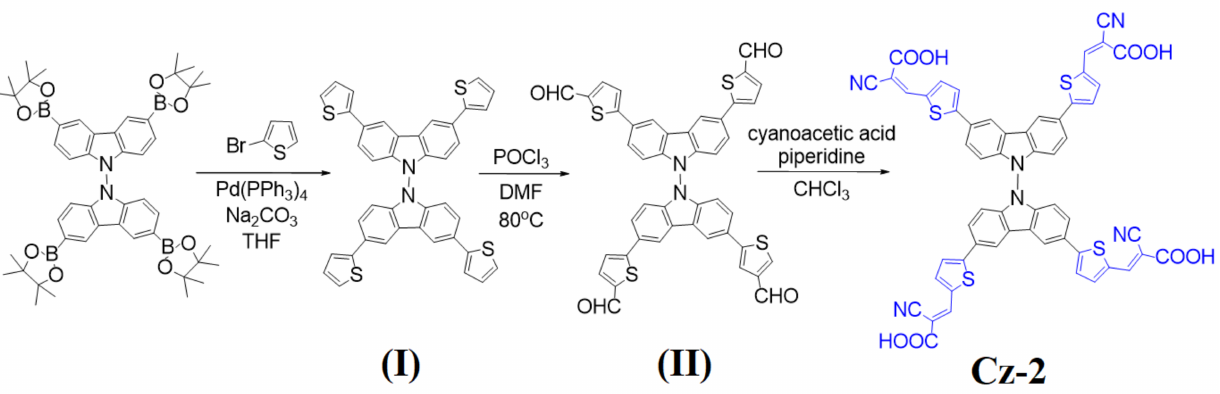
Figure 1. Synthetic route for the preparation of Cz-2